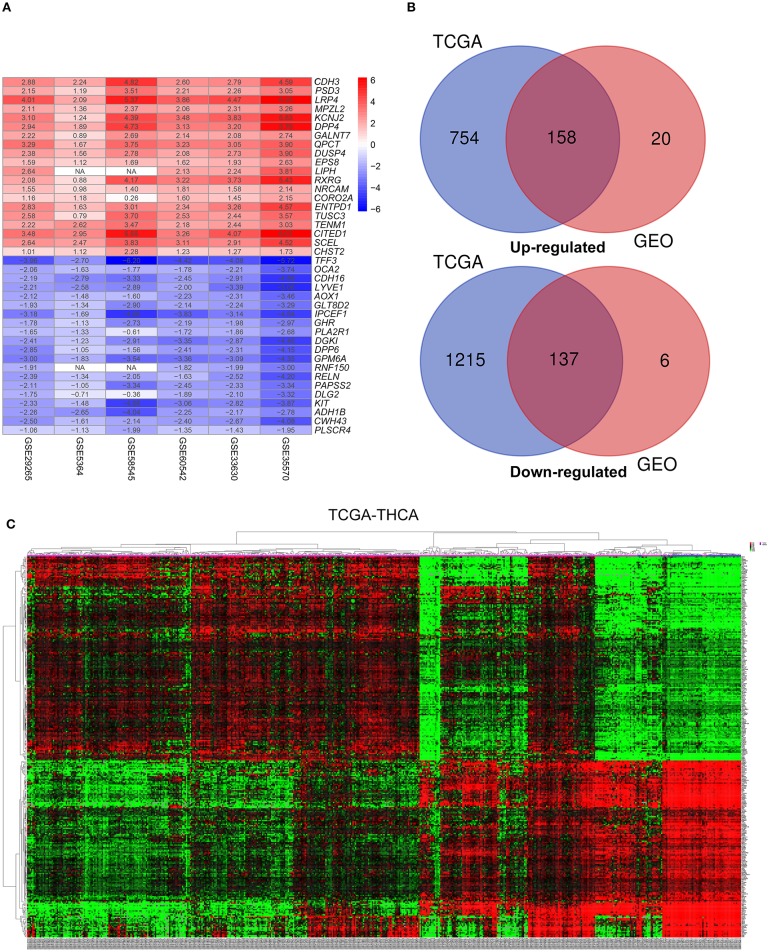
Identification of differentially-expressed genes (DEGs) between tumor tissues and normal tissues in papillary thyroid carcinoma (PTC). (A) The heatmap presenting the top 20 upregulated and downregulated DEGs in PTC after integrated analysis of the six GEO datasets using the robust rank aggregation (RRA) method. (B) From this, 295 reliable DEGs including 158 upregulated and 137 downregulated genes were identified based on the intersection between GEO and TCGA results. The upregulated DEGs are shown in red while the downregulated DEGs are shown in blue. The value of Log2FC was presented in each column. (C) A representative heatmap of TCGA-THCA dataset revealed that the 295 reliable DEGs have significantly different expression patterns between tumor and non-tumor tissues, which can distinguish these tissue types.